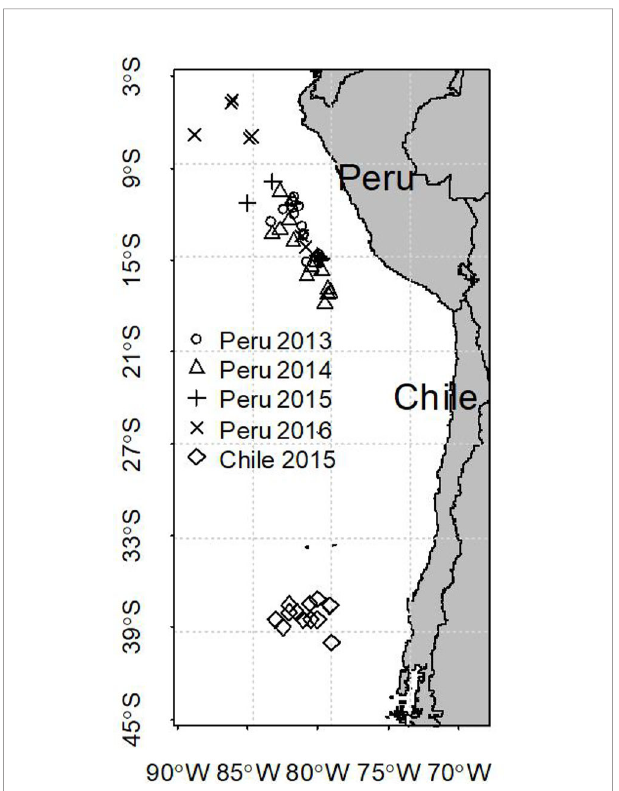
FIGURE 1 | Map of the sampling locations of D. gigas in southeastern Paci fi